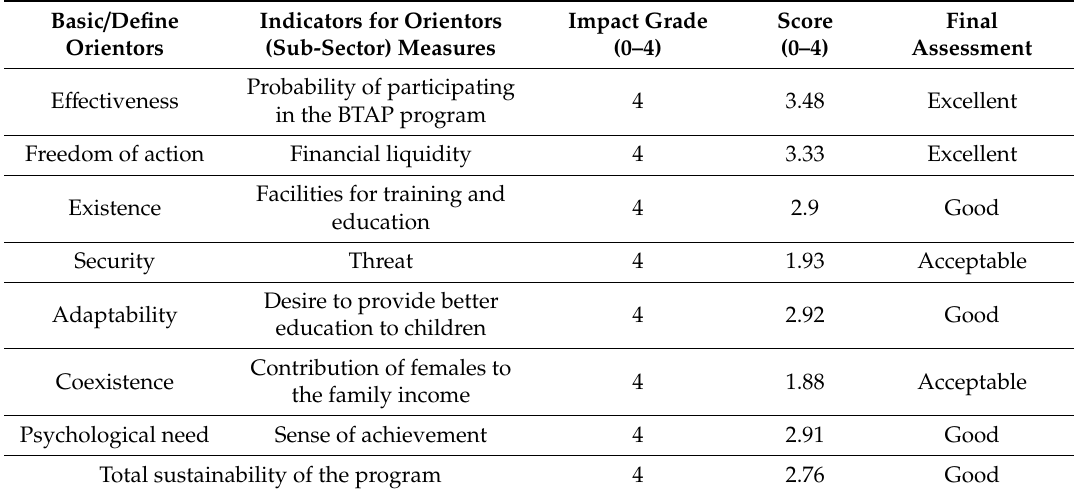
Table 4. Assessment of the social impacts of the BTAP in the Malakand Division of KPK, as a “sustainable